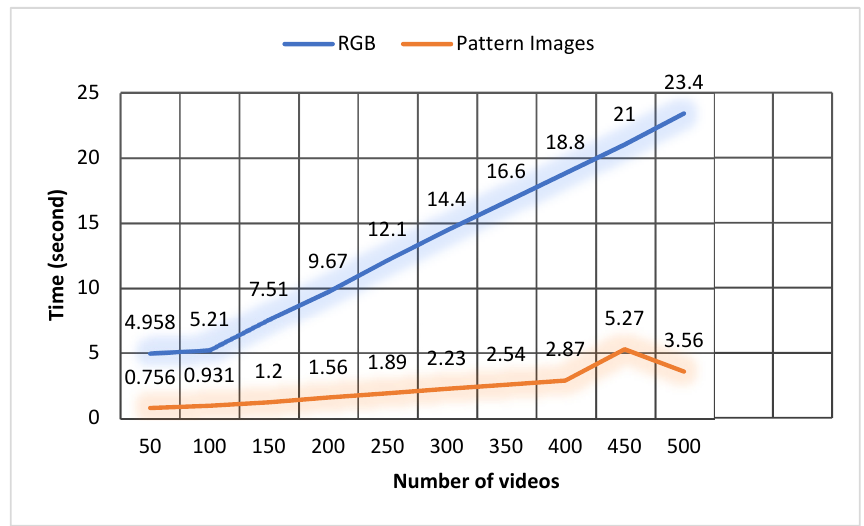
Figure 7. Actual Running Time Analysis as the number of videos increase.